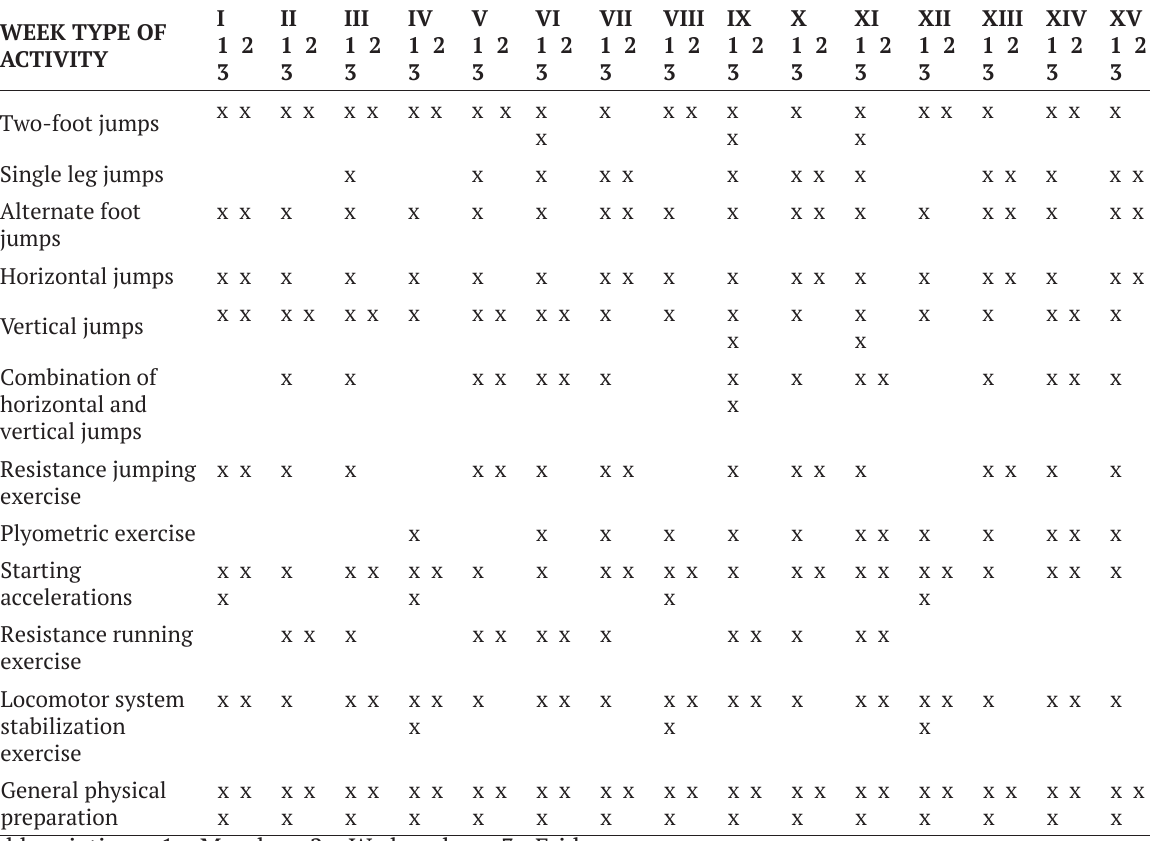
Table 1. Plan of the 15-week experimental program WEEK TYPE OF